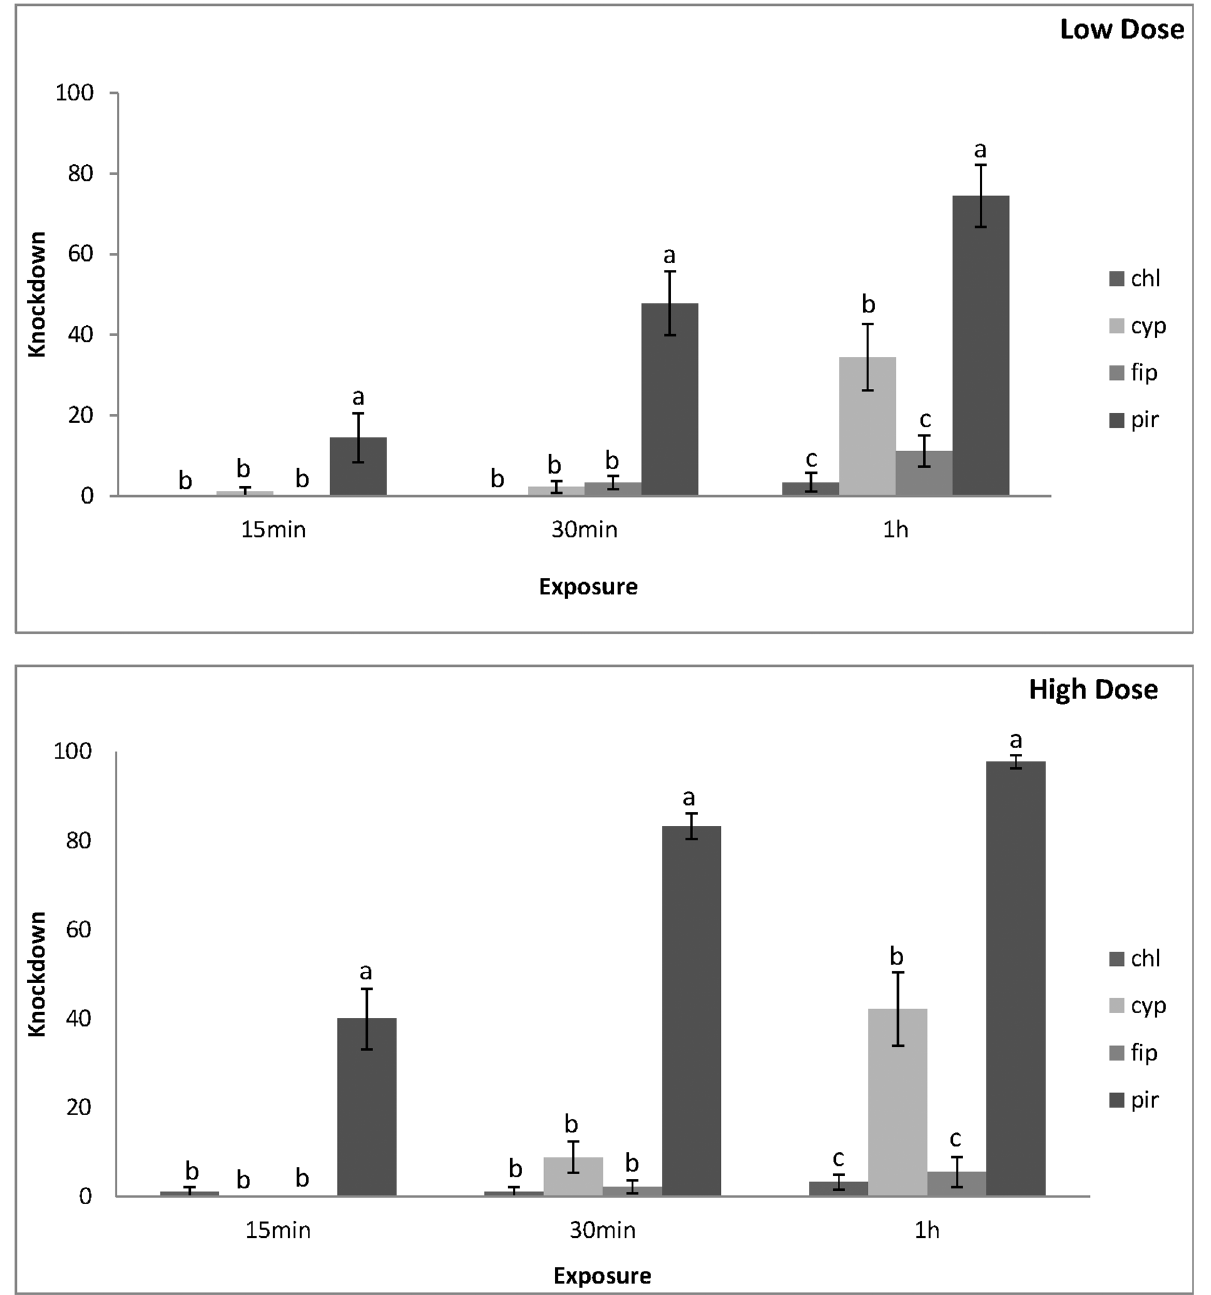
Fig 4. Mean Knockdown of O . surinamensis adults on metal surfaces at low and high dose. Mean Knockdown (% ± SE) of O . surinamensis adults on metal treated with chlorfenapyr (chl), alpha-cypermethrin (cyp), fipronil (fip) and pirimiphos-methyl (pir), at the low and the high dose rate of each insecticide after 15 min, 30 min and 1 h exposure